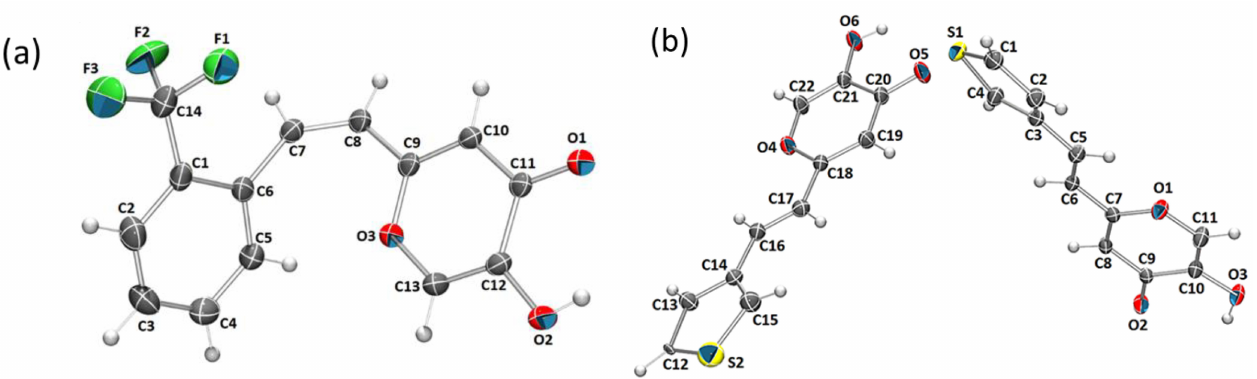
Figure 14. Molecular structure of compounds cis - 2 ( a ) and trans - 6 ( b ). Displacement ellipsoids are drawn for the probability of 25%, and hydrogen atoms are shown as spheres of arbitrary